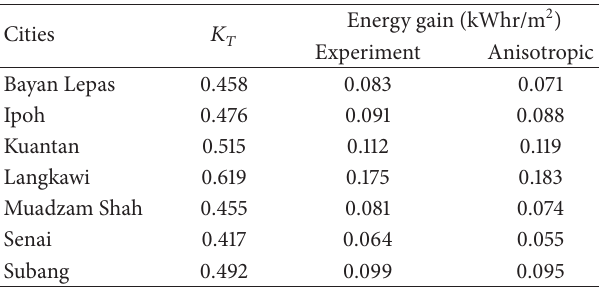
Table 2: Energy gain based on experimental curve and isotropic model on morning